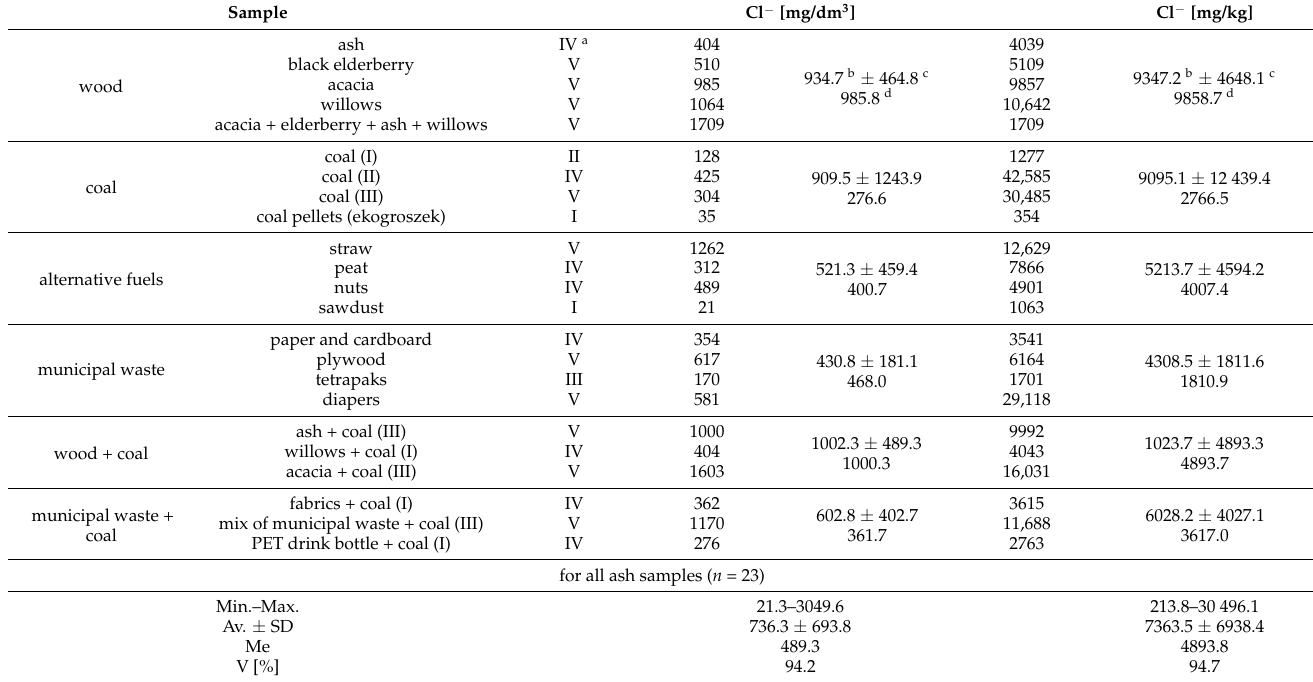
Table 2. Statistical parameters for chloride leaching from